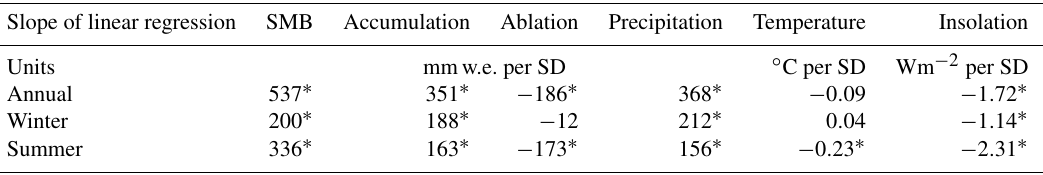
Table 1. Slope of the linear regression of the annual (April to March) time series of the spatially averaged SMB with the annual (April to March), winter (April to September), and summer (October to March) time series of the spatially averaged fields of SMB, accumulation, ablation, accumulated precipitation, mean temperature, and mean insolation. Slope of linear regression SMB Accumulation Ablation